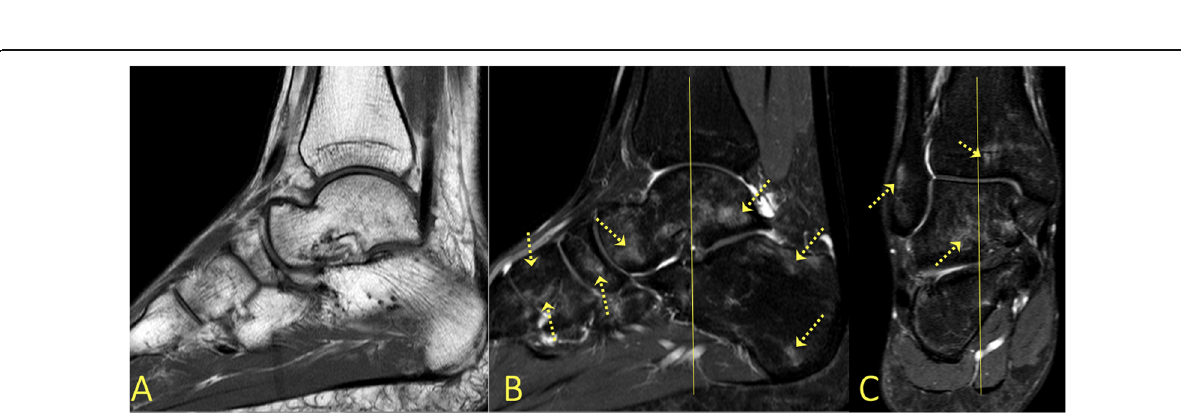
Fig. 32 A 21-year-old male with inactive osteopenia after immobilization for some weeks. Patchy lesions are visible in all bones (dashed